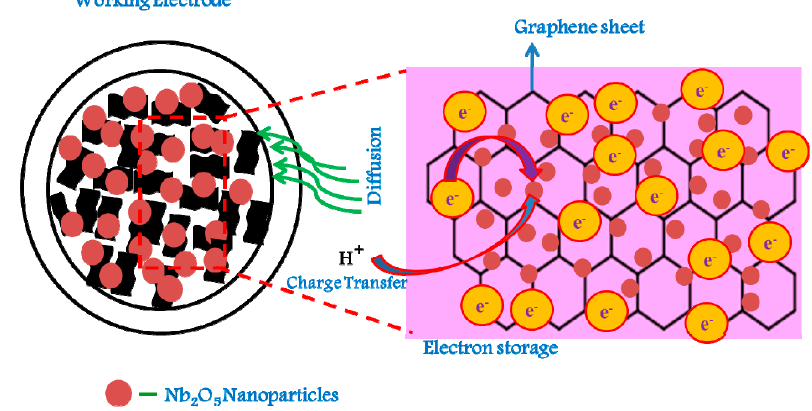
Scheme 1. Schematic of the charge-storage mechanism of the Nb 2 O 5 / G composite